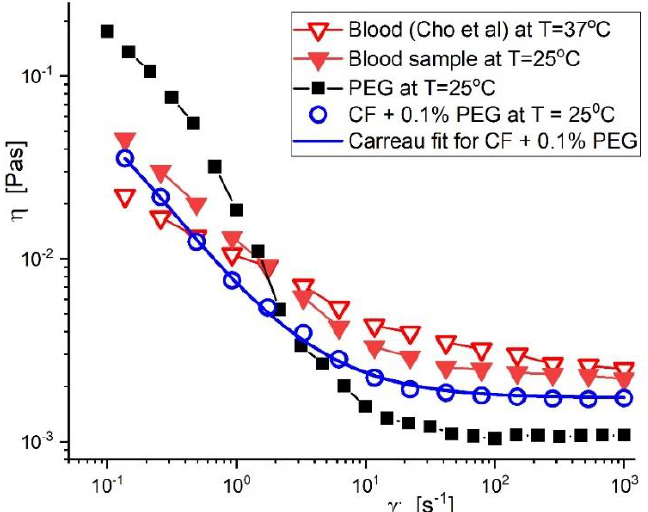
Figure 4. Viscosity curves for blood (values from literature and healthy volunteer), PEG − coated functionalized nanocomposite (PEG_MNC), and model suspension fluid (carrier fluid + 0.1% PEG_MNC).